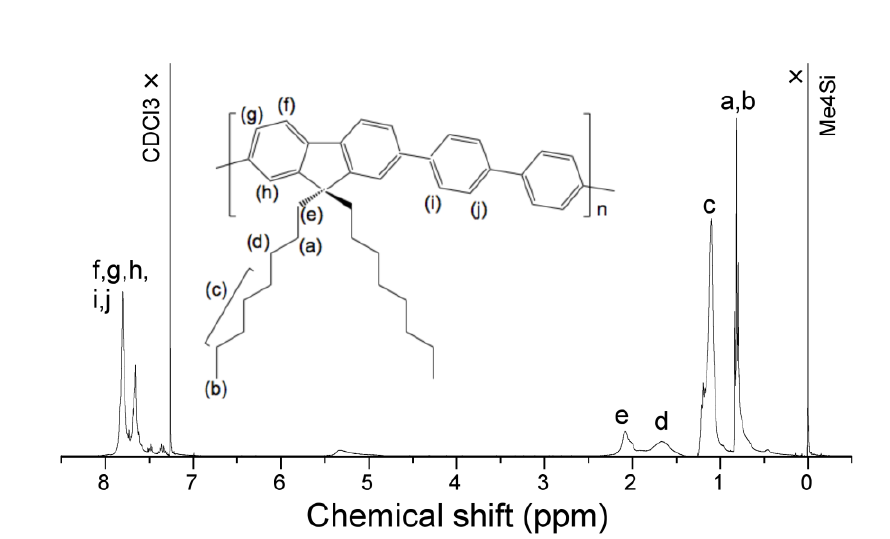
) Si as an internal standard 3 4